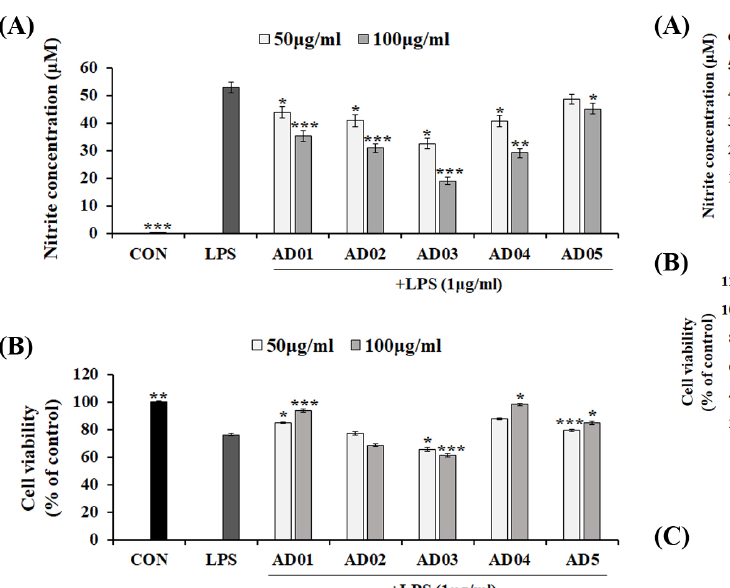
Fig. 2: Effects of A. distichum methanol crude extract and its fractions on NO production (A) and cell viability (B) in LPS-stimulated RAW 264.7 cells. RAW264.7 cells were treated with or without LPS in the presence of A. distichum methanol crude extract and its fractions for 24 h. The amounts of NO were determined using the Griess reagent in the culture medium, and cytotoxicity was determined by MTT assay. Values are the mean ± SD of triplicate experiments. * p < 0.05, ** p < 0.01, and *** p < 0.001 represent the significant differ- ences in comparison with the cells treated with LPS alone. MeOH extract; AD01, hexane fraction; AD02, ethyl acetate fraction; AD03, n-butanol fraction; AD04, aqueous fraction; AD05.